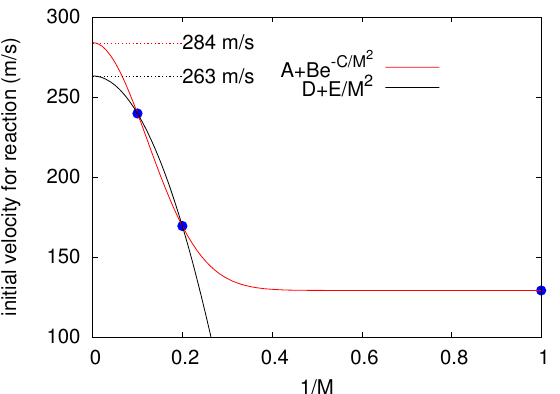
Figure 12. Extrapolation of initial velocity allowing for electron hopping to M → ∞